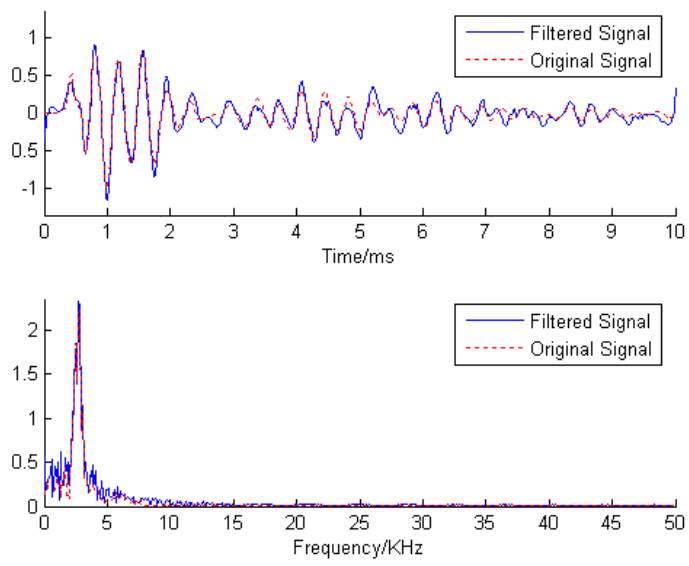
Figure 7. The denoised stress wave signal using proposed